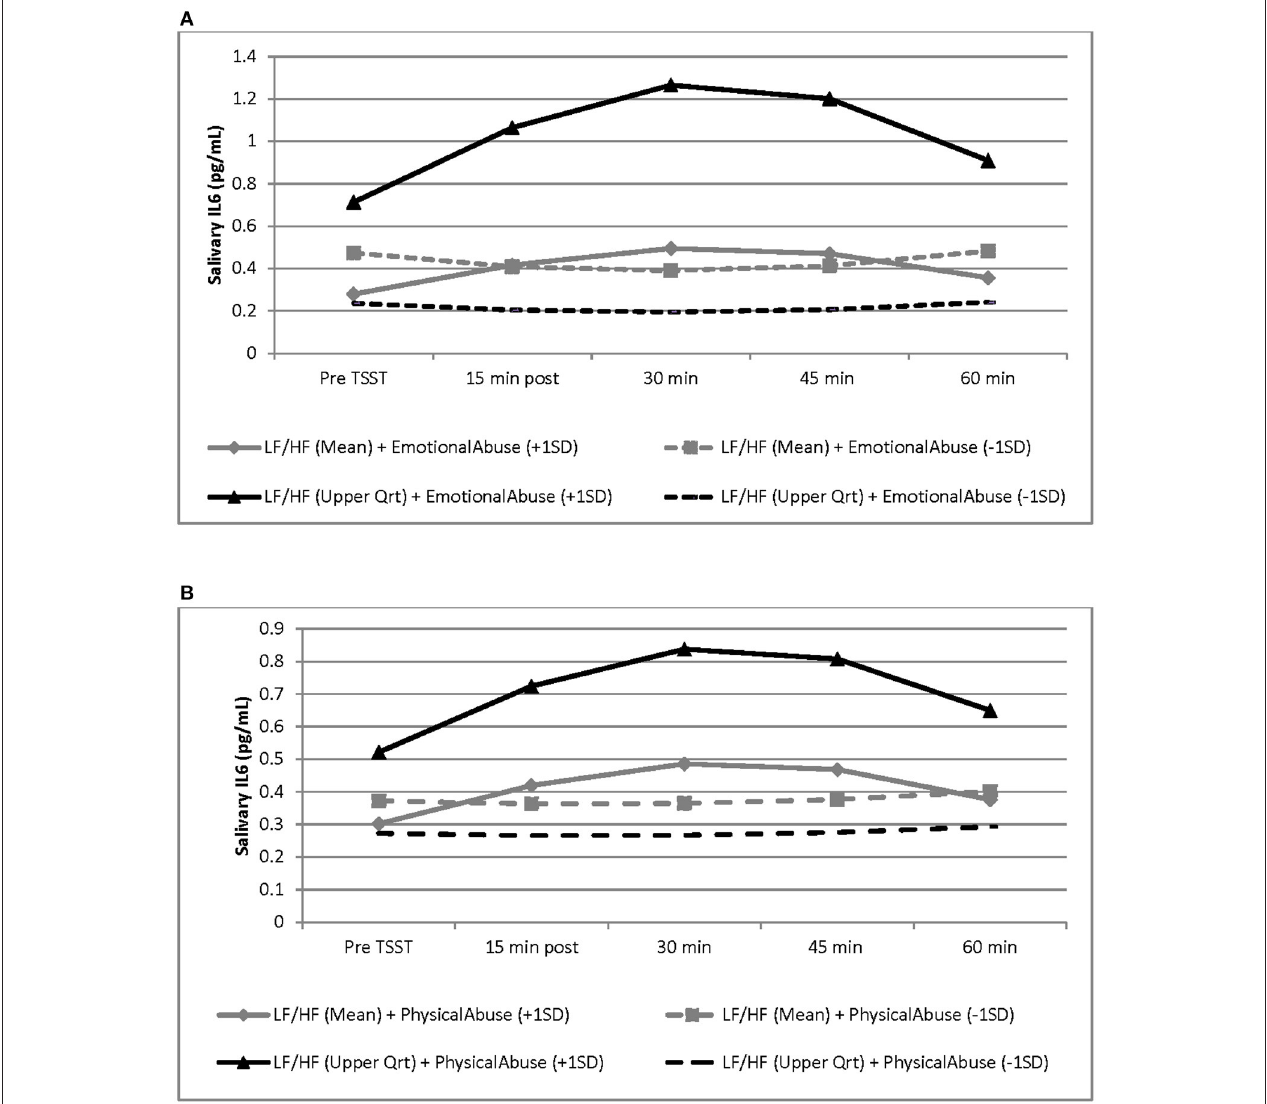
FIGURE 2 | Graphical representation of the interaction between LF/HF-HRV and childhood adversity factors (i.e., emotional abuse and physical abuse) and the effects of these interactions on the salivary IL-6 response to the TSST. These effects are modeled as sample mean/upper quartile values for LF/HF ratio and as ± 1 SD of the sample mean values for emotional and physical abuse subscales. Graphs are estimated by the hierarchical linear models from baseline (before TSST) to 60min post TSST. N = 34. SD, standard deviation; SE, standard error. (A) For men with higher LF/HF-HRV, greater exposure to emotional abuse was associated with a more intense IL-6 response to the TSST, as compared to lower exposure to emotional abuse, and as compared to men with average LF/HF ratio (b = 1.7379, SE = 0.6396, p = 0.010). Black line represents LF/HF upper quartile values; gray lines represent LF/HF grand mean values; solid lines represent emotional abuse subscale scores at + 1 SD; dashed line represents emotional abuse subscale scores at − 1SD. (B) For men with higher LF/HF-HRV, greater exposure to physical abuse was associated with a more intense IL-6 response to the TSST, as compared to lower exposure to physical abuse, and as compared to men with average LF/HF ratio (b = 1.0746, SE = 0.3803, p = 0.007). Black line represents LF/HF upper quartile values; gray lines represent LF/HF grand mean values; solid lines represent physical abuse subscale scores at + 1 SD; dashed line represents physical abuse subscale scores at − 1